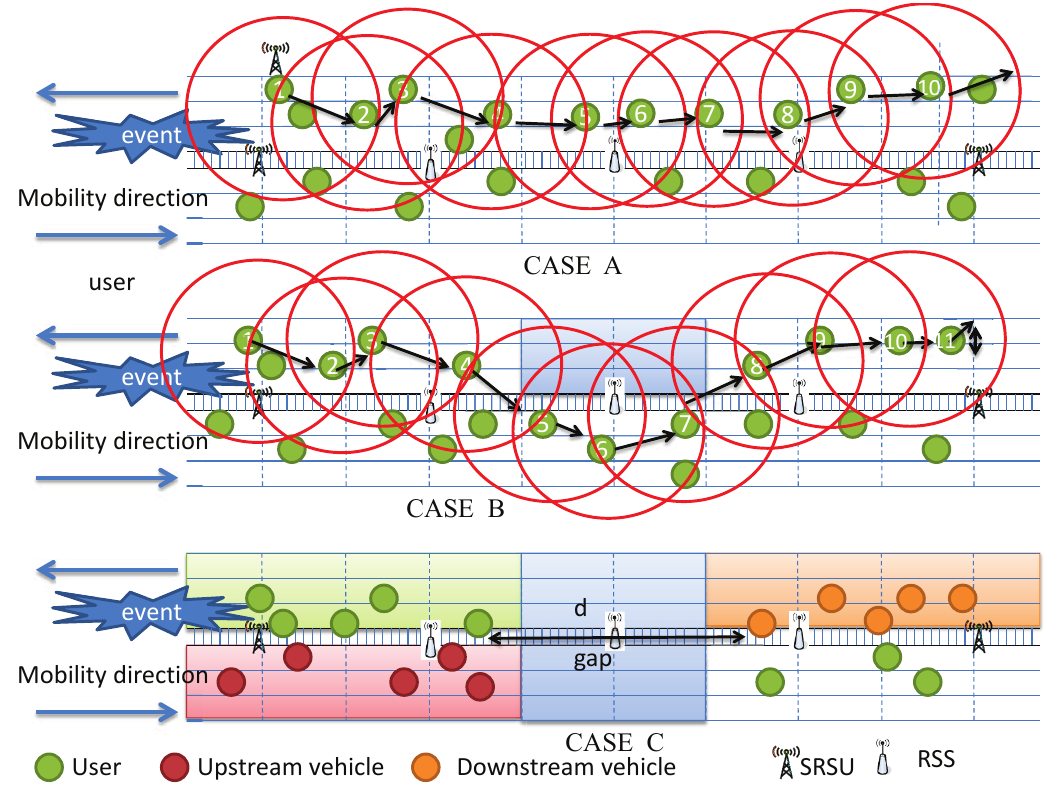
Figure 6. All possible ways of message forwarding. ( i ) Case A: message forwarding through vehicles moving along the same direction (downstream); ( ii ) Case B: message forwarding through vehicles moving along the opposite direction (upstream); ( iii ) Case C: message forwarding through RSS when the network is